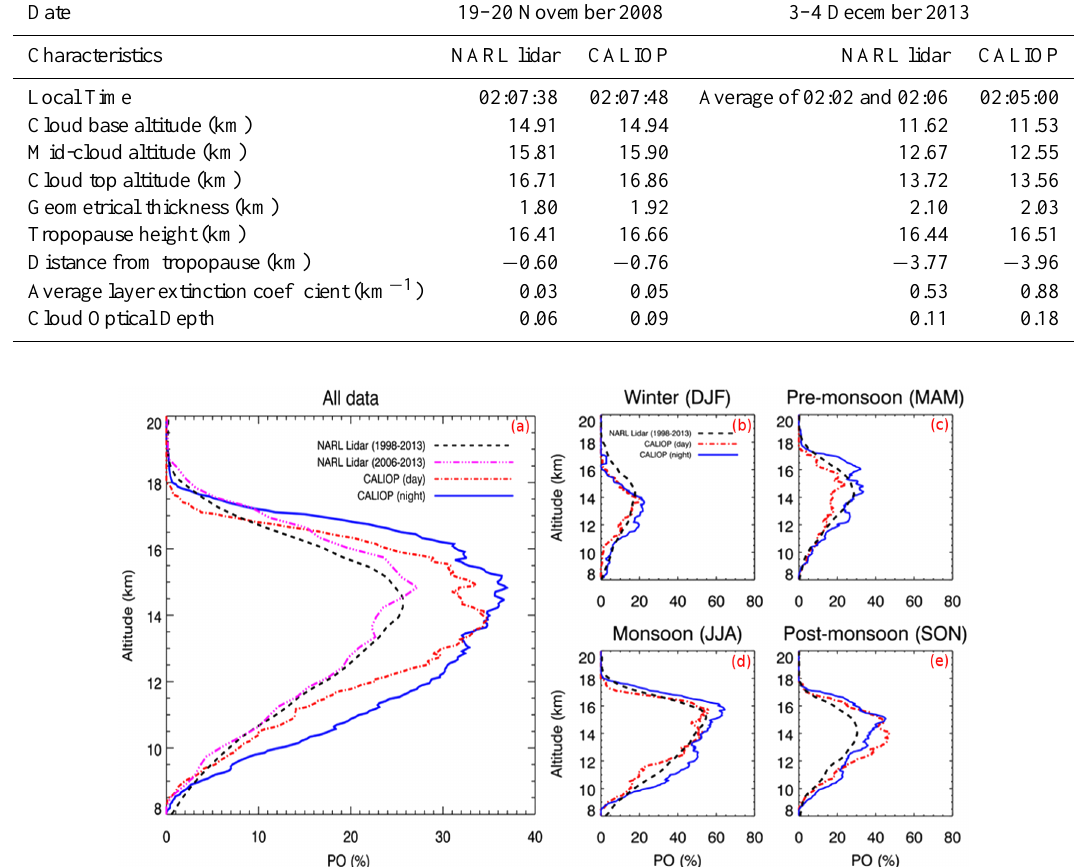
Table 2. Macrophysical and optical properties of cirrus cloud layer detected using NARL lidar and CALIOP on 19–20 November 2008 and